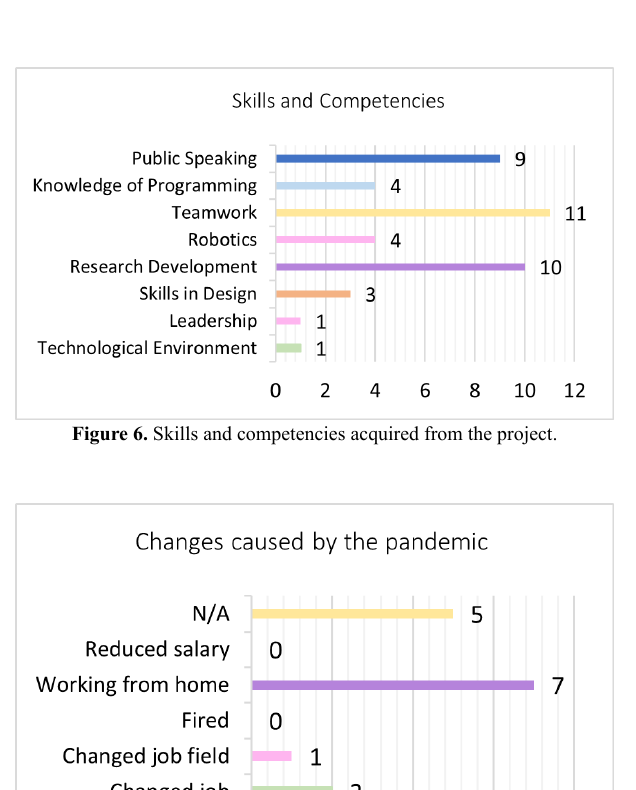
Figure 5. Influence of the project on the professional trajectory of graduates (questionnaire 2).